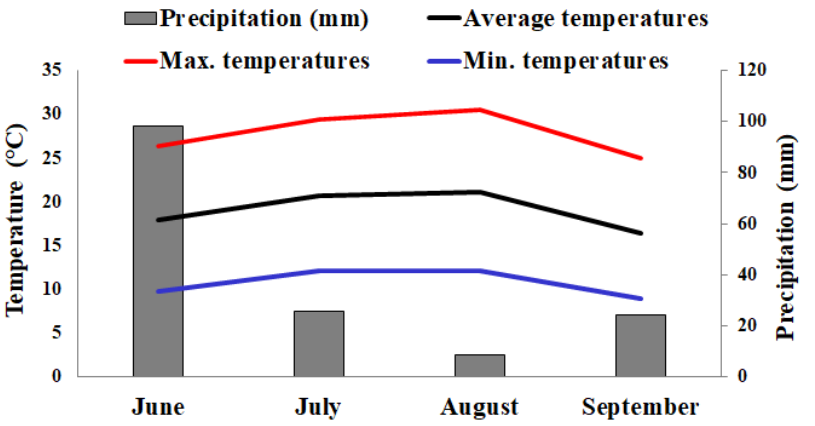
Figure 1. Meteorological data for Pignola, Potenza, Italy, registered from June to September 2021. Data were provided by the Agrometeorological Service of the Basilicata Region, Italy. June was the month when the T . harzianum T22 inoculation and transplantation of tomato seedlings were carried out; July: vegetative growth and flowering stages; August: stages of establishment and development of fruit; September: fruit maturity stage and harvesting of tomato fruit.